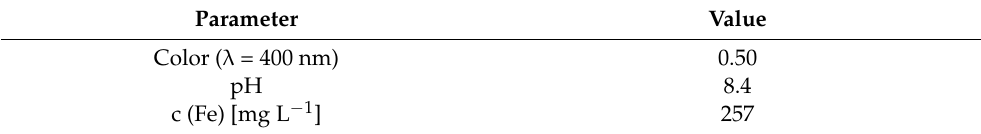
Table 2. Parameters of the HAs solution in tap